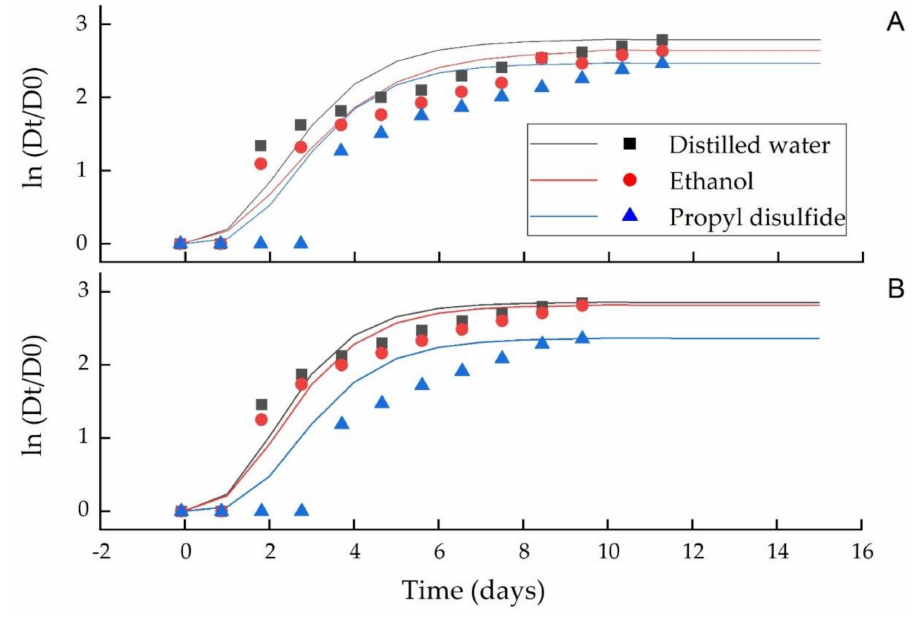
Figure 5. Effect of PD in the vapor diffusion assay on the growth of C. acutatum ( A ) and C. gloeospo- rioides ( B ). The mycelial growth presented is the mean of five replicates ± SD at p ≤ 0.05. Dt is the average colony diameter at time t and D0 is the average colony diameter at initial time, fitted (distilled water, ethanol and propyl disulfide) with the modified Gompertz model.